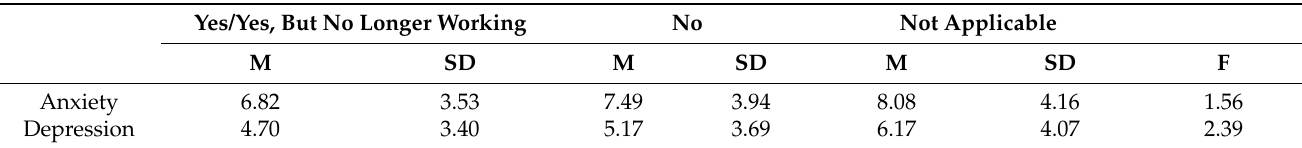
Table 14. Comparisons between symptoms of anxiety and depression in respondents working and not working in a COVID-19